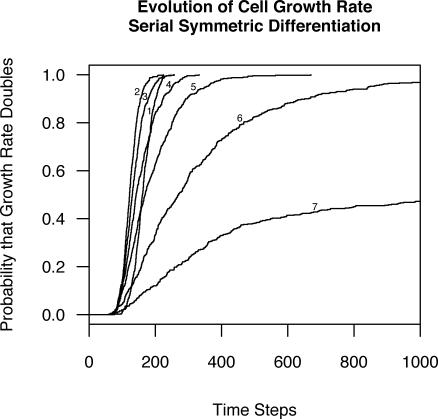
Kaplan-Meier Curves for the Probability that a Population of Cells Doubles Its Average Growth Rate as a Function of TimeEach curve is labeled with the number of differentiation stages in the model (1 = self-duplication with no differentiation).